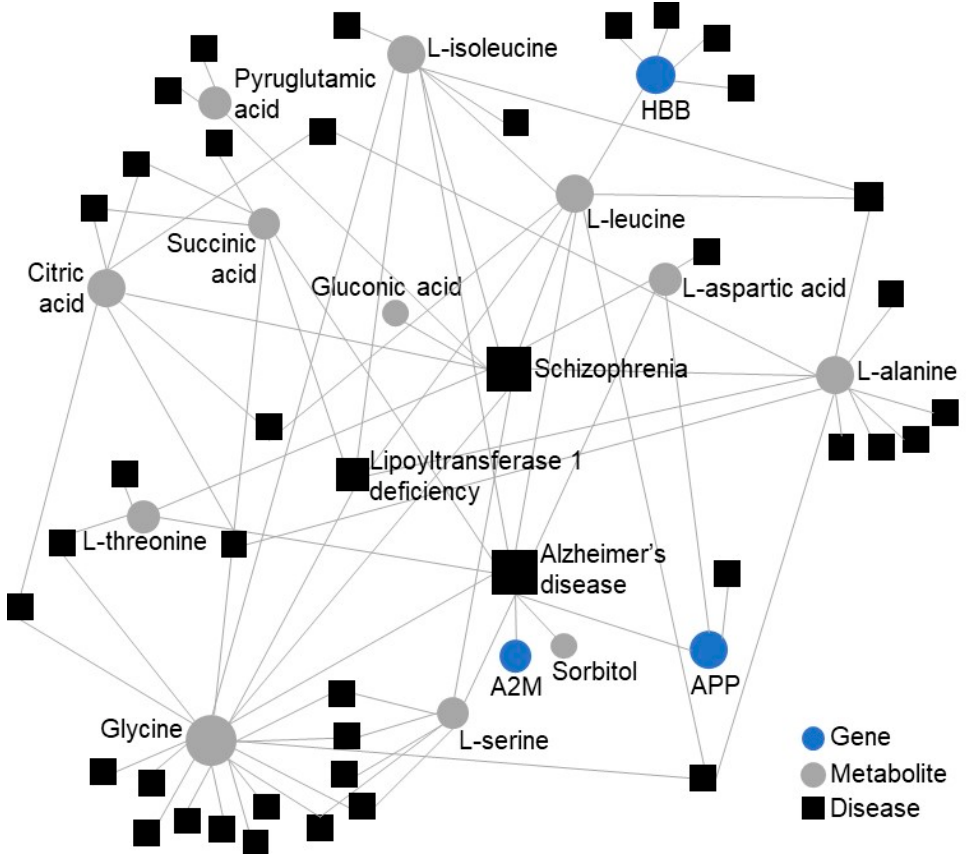
Figure 3 . Metabolite–gene–disease interaction network in CAVD. Metabolite–gene–disease network based on the input of 19 differentially abundant metabolites and the 7 overlapping genes between transcriptome and proteome and its 14 connector genes from Figure 2B. The predicted network is based on the betweenness of the interacting molecules. The node size scales indicate the degree (connectivity) of nodes in the network. Gray nodes: metabolites. Blue nodes: input genes. Black squares: disease.